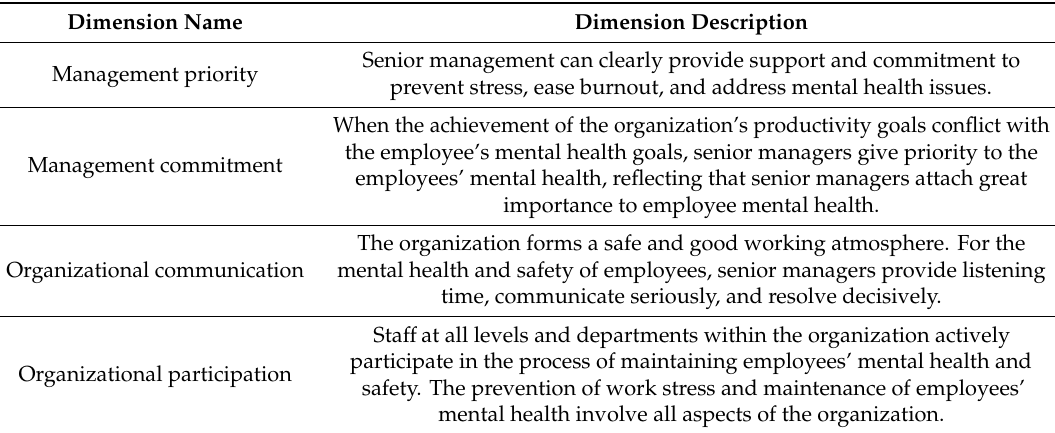
Table 1. Psychosocial safety climate (PSC) dimensions.